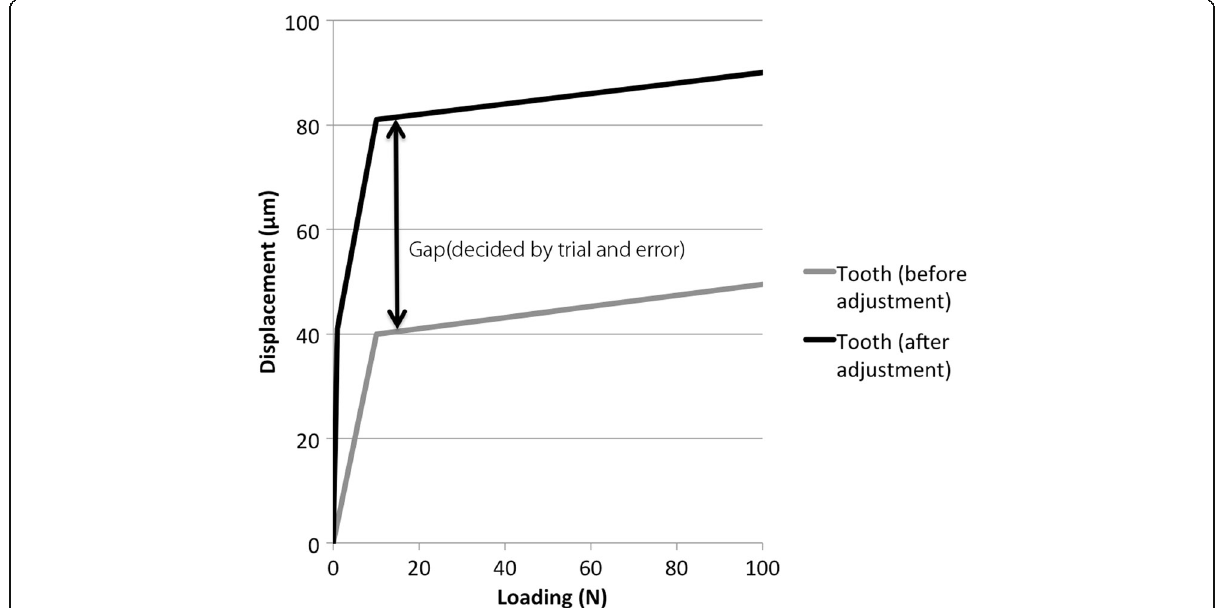
Fig. 7 Initializing models altering the load displacement curves of